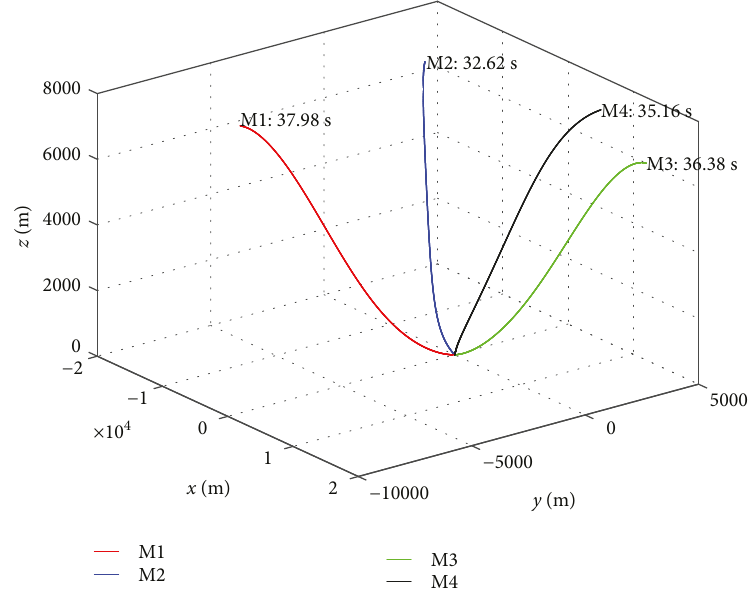
Figure 5: 3D trajectories by the PN guidance law.